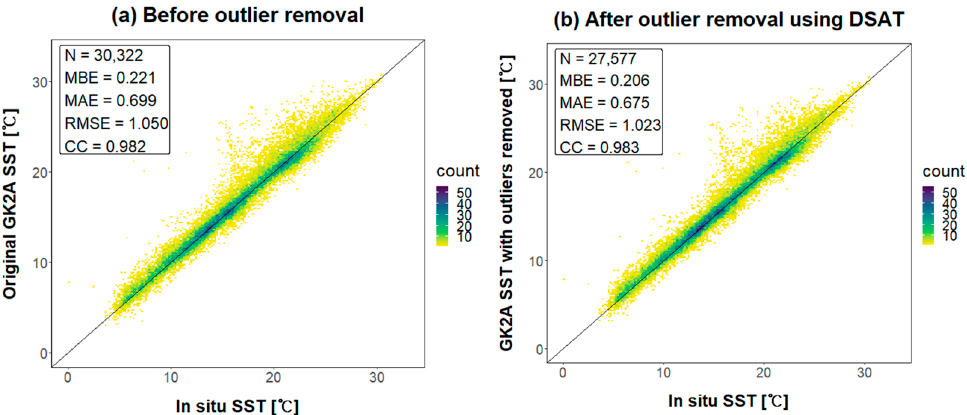
Figure 10. Scatter plots for the in situ and the GK2A SST ( a ) before outlier removal and ( b ) after outlier removal using DSAT.